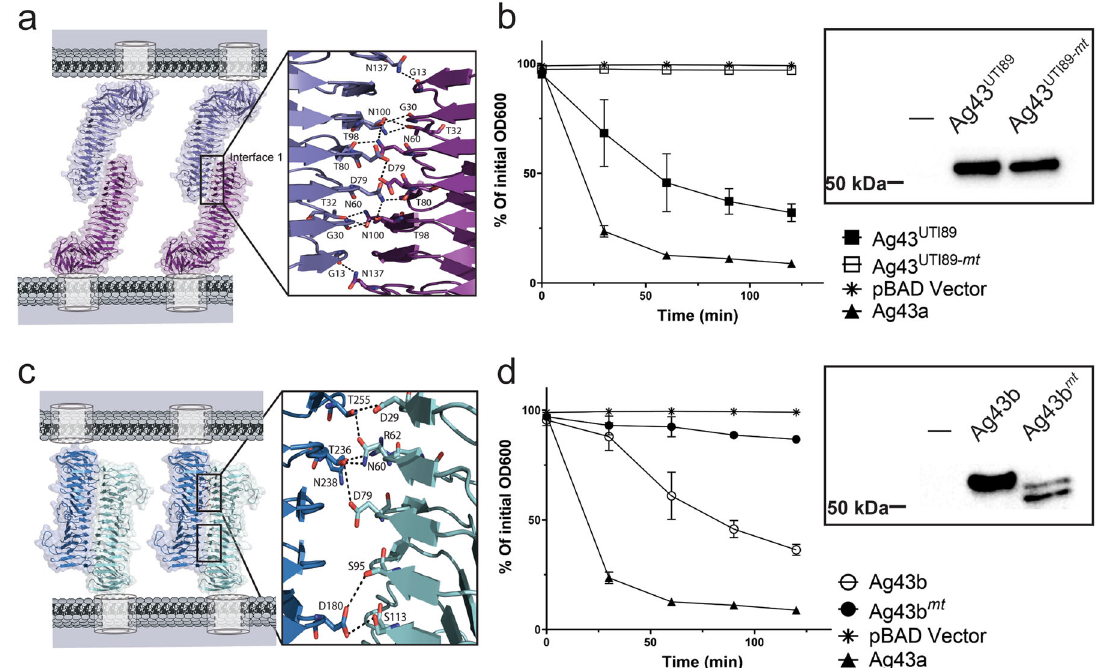
Fig. 3 Ag43 interfaces with reduced self-association interactions. a Self-association of α 43_UTI89 via a single interface consisting of 13 hydrogen bonds [G13-N137, G30-T98, T32-N100 (two hydrogen bonds), N60-T98, N60-T80, D79-D79, T80-N60, T98-G30, T98-N60, N100-T32 (two hydrogen bonds) and N137-G13]. b Con fi rmation of the α 43_UTI89 self-association interface shown by the aggregation pro fi le of MS528 expressing the interface mutant Ag43 UTI89- mt (T32G, N60G, D79G, T80G, T98G, N100G, N137G), WTAg43 UTI89 , WTAg43a and the control pBAD/ Myc-HisA plasmid. The expression of the heat-released Ag43 α -domain was examined by western blot analysis (inset). c Self-association of α 43b via a double interface with each consisting of seven hydrogen bonds [D29-T255, N60-T255, R62-N238, D79-T236, S95-D180, S113-D180 and N60-T236]. d Con fi rmation of the α 43b self-association interface shown by the aggregation pro fi les of MS528 expressing the interface mutant Ag43b mt (D29G, N60G, R62G, D79G and S95G), WT Ag43b, WT Ag43a and the control pBAD/Myc-HisA plasmid. The expression of the heat- released Ag43 α -domain was examined by western blot analysis (inset). Error bars correspond to the standard deviation calculated from three independent experiments.